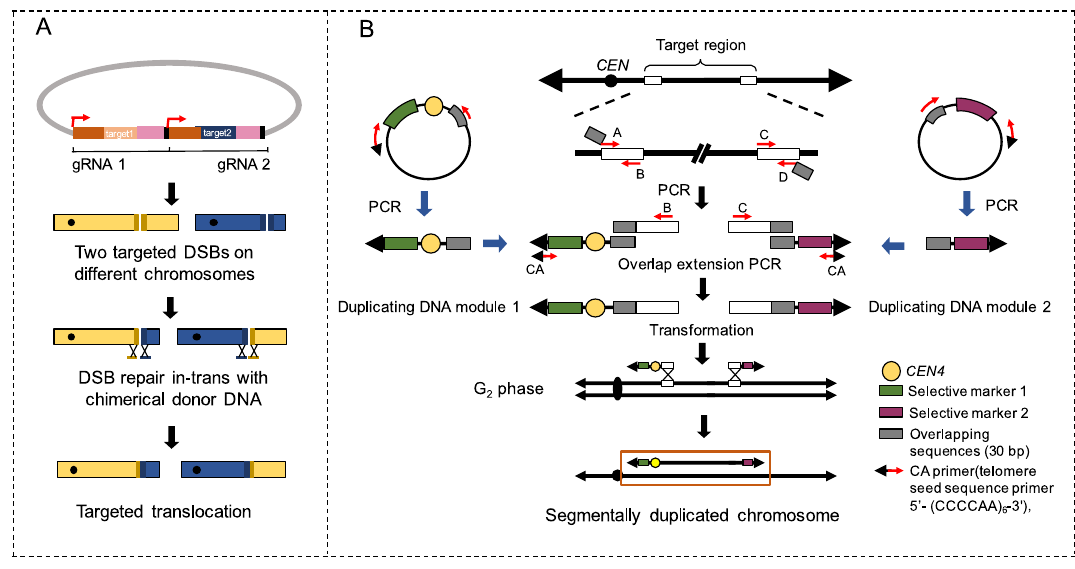
Figure 2. Two methods to generate on-demand chromosomal rearrangements. ( A ) Generation of targeted translocation with CRISPR-Cas9. Using two different gRNAs, two DSBs are simultaneously generated on different chromosomes by Cas9. DSBs are then repaired in trans with a chimerical donor DNA oligonucleotide, resulting in designed translocation. ( B ) PCR-mediated construction of a segmentally duplicated chromosome. The most left/right regions (400 bp; white rectangle) of a target region were amplified by PCR. The primers A, B, C, and D varied with the target site. A DNA fragment containing a centromere ( CEN4 ) and the selective marker 1 cassette, paired with the PCR product that was produced by primers A and B, were used to generate “duplicate DNA module 1” by overlap extension PCR. Similarly, a DNA fragment containing the selective marker 2 and the PCR product produced by primers C and D were used to amplify “duplicate DNA module 2”. Duplicate DNA modules were then introduced into yeast cells to duplicate the selected region by homologous recombination and DNA replication.